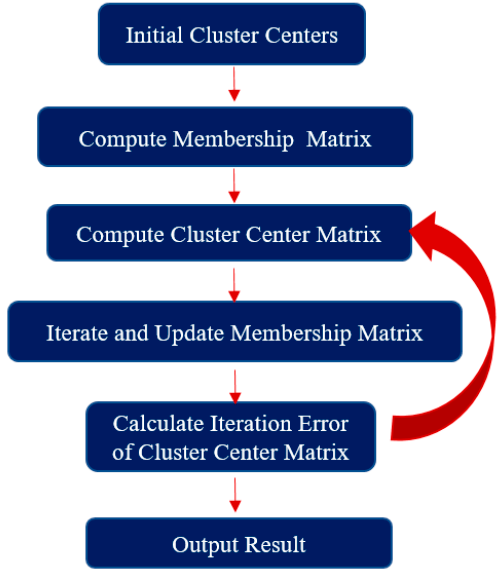
Figure 4. A flow chart of the fuzzy C-means cluster.